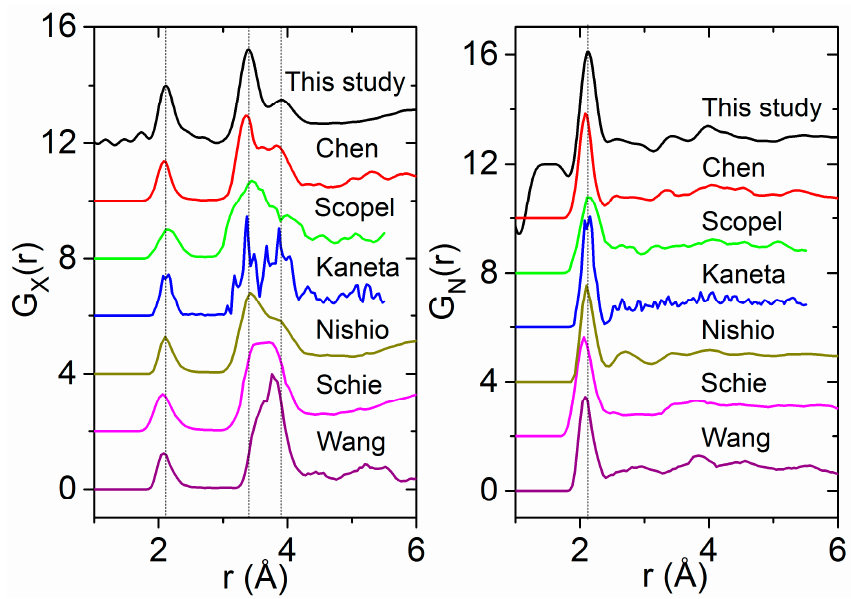
Figure 7. Comparison of our experimental pair distribution functions for amorphous HfO 2 (black, top) with several molecular dynamics simulations taken from the literature [2,3,5–7,61] and weighted for: X-rays ( Left ); and neutrons ( Right ). Table 2. Comparison of local structure: Hf–O and Hf–Hf distances and coordination numbers for liquid and amorphous hafnia obtained from experiment and simulation. Coordination numbers, Hf–O bond lengths, and Hf–Hf distances for the cubic and monoclinic polymorphs are included for comparison.